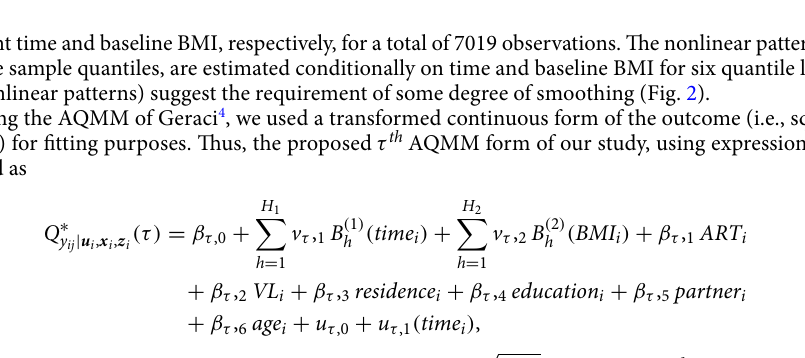
Figure 2. Observed CD4 counts (square root transformed) by time and baseline